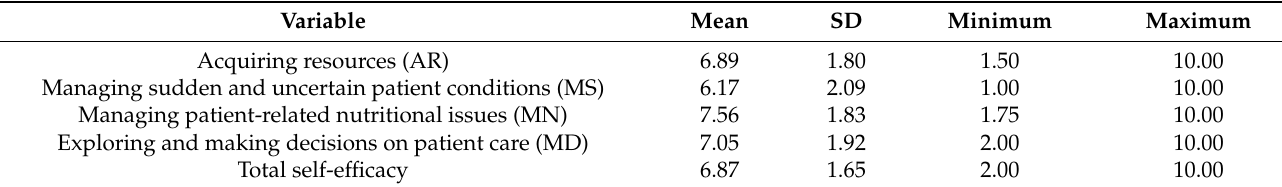
Table 3. Caregiving self-efficacy in primary family caregivers ( n =